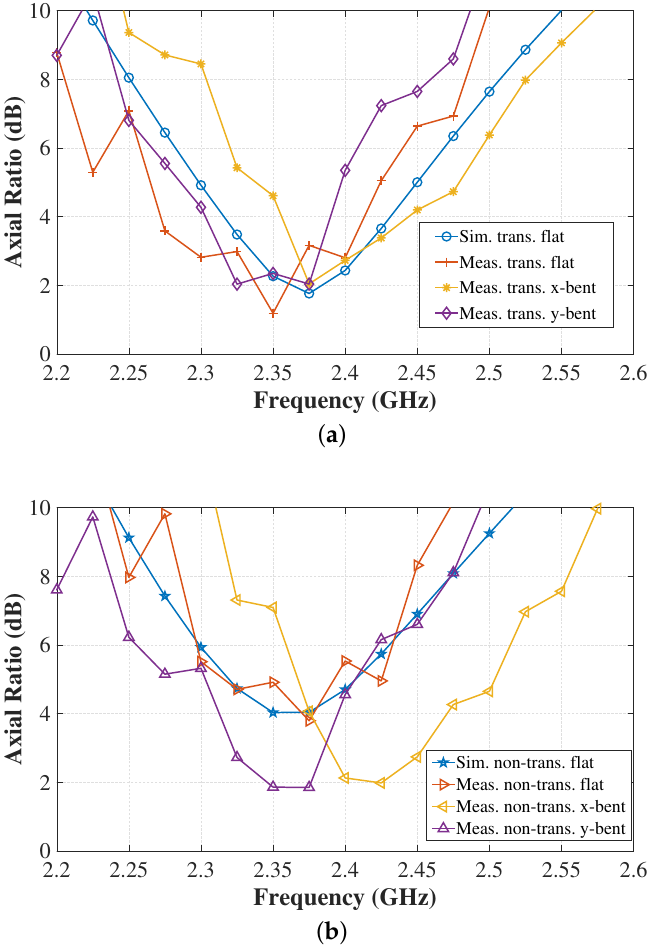
Figure 26. Simulated and measured axial ratio vs. frequency: ( a ) transparent antenna, ( b ) non- transparent antenna.